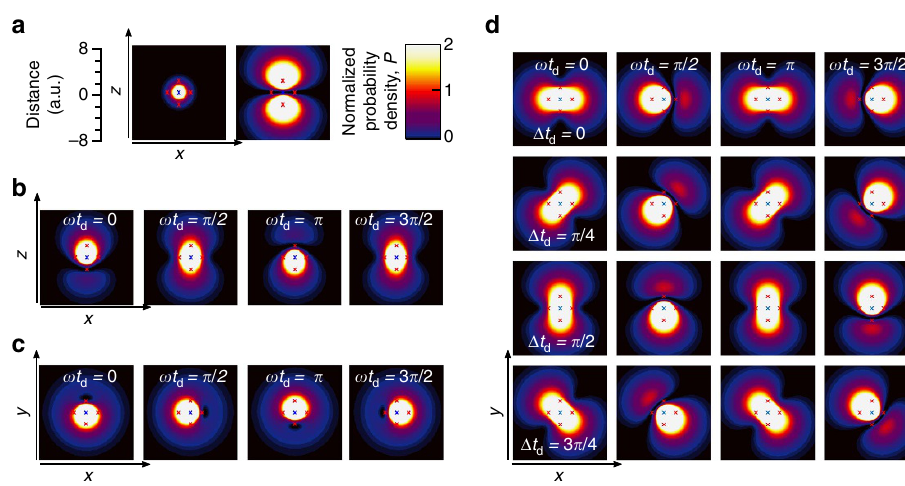
Figure 1 | Control of hydrogen orbital wavefunctions using superposition states. Heat maps of the probability density function are shown ( a , b are cross-sections in the x–z plane and c , d are in the x–y plane). The probability density was normalized in each frame so that the probability of finding the electron in a region with P Z 1 is 50%. The red contour thus encloses 50% of the integrated probability density. Blue crosses show the origin and red crosses are located at (0, ± 2 a (cid:2) ) and ( ± 2 a (cid:2) , 0) in-plane for reference where a (cid:2) is the Bohr radius. ( a ) The ground state 1 s and 2 p 0 excited state are o o o examples of states which can be superposed using an intense light pulse. ( b ) An example of the 1 s and 2 p 0 in an equal admixture, generated after applying a z -polarized p /2-pulse shown as a function of time. The superposition phase, j ¼ o t , where : o is the energy separation between the two basis states. ( c ) Time evolution of an equal admixture between the 1 s and 2 p (cid:3) states, which could be produced with a s (cid:3) circularly polarized light pulse shown as a function of time. ( d ) Admixture between the 1 s , the 2 p (cid:3) and the 2 p þ following a short pulse with area O t p ¼ O 2 p /4 (starting from 1 s ) shown as a function of time. The fast oscillation along the rows evolves with phase o t and the slow rotation from row to row evolves with phase D t , where : o is the average transition energy (9.47THz) and 2 : D is the difference between the excited